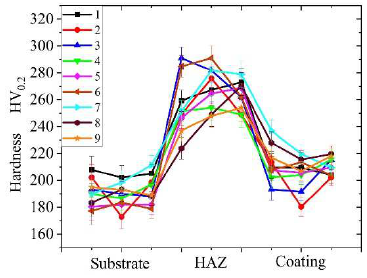
Figure 7. Microhardness of specimens.